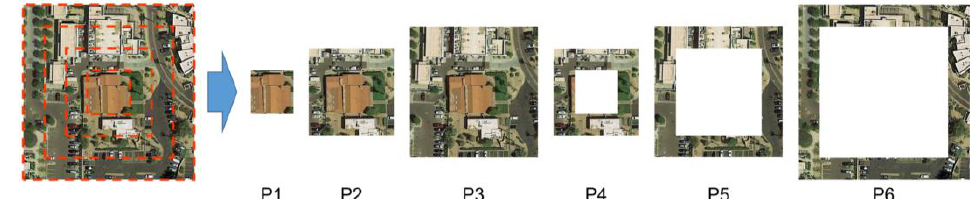
Figure 3. Improved block strategy. Feature map is divided into six blocks of the above shape.